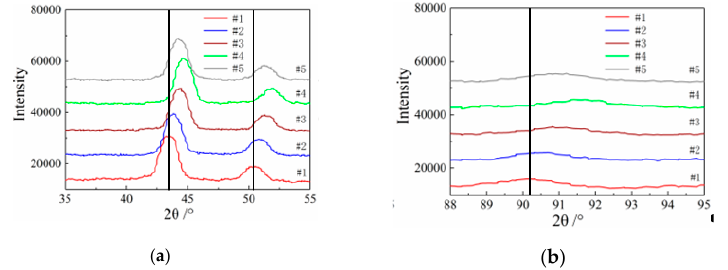
Figure 11. The diffraction peaks of the specimens for different cryogenic parameters. ( a ) 35°–55°diffraction peak distribution of specimens. ( b ) 88°–95°diffraction peak distribution of specimens.